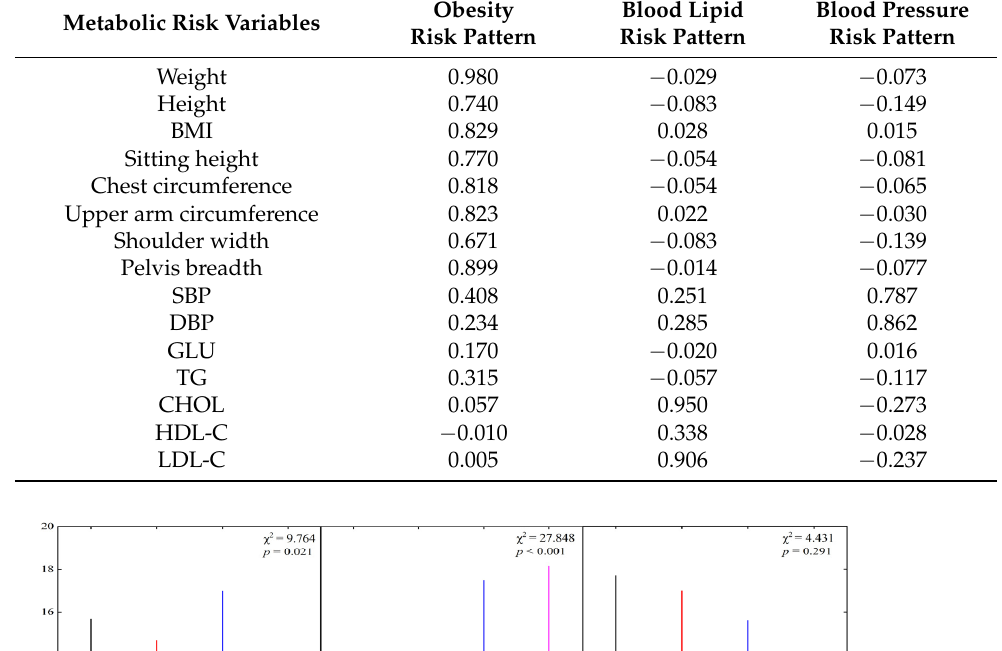
Table 5. Factor loadings for metabolic risk patterns. Metabolic Risk Variables